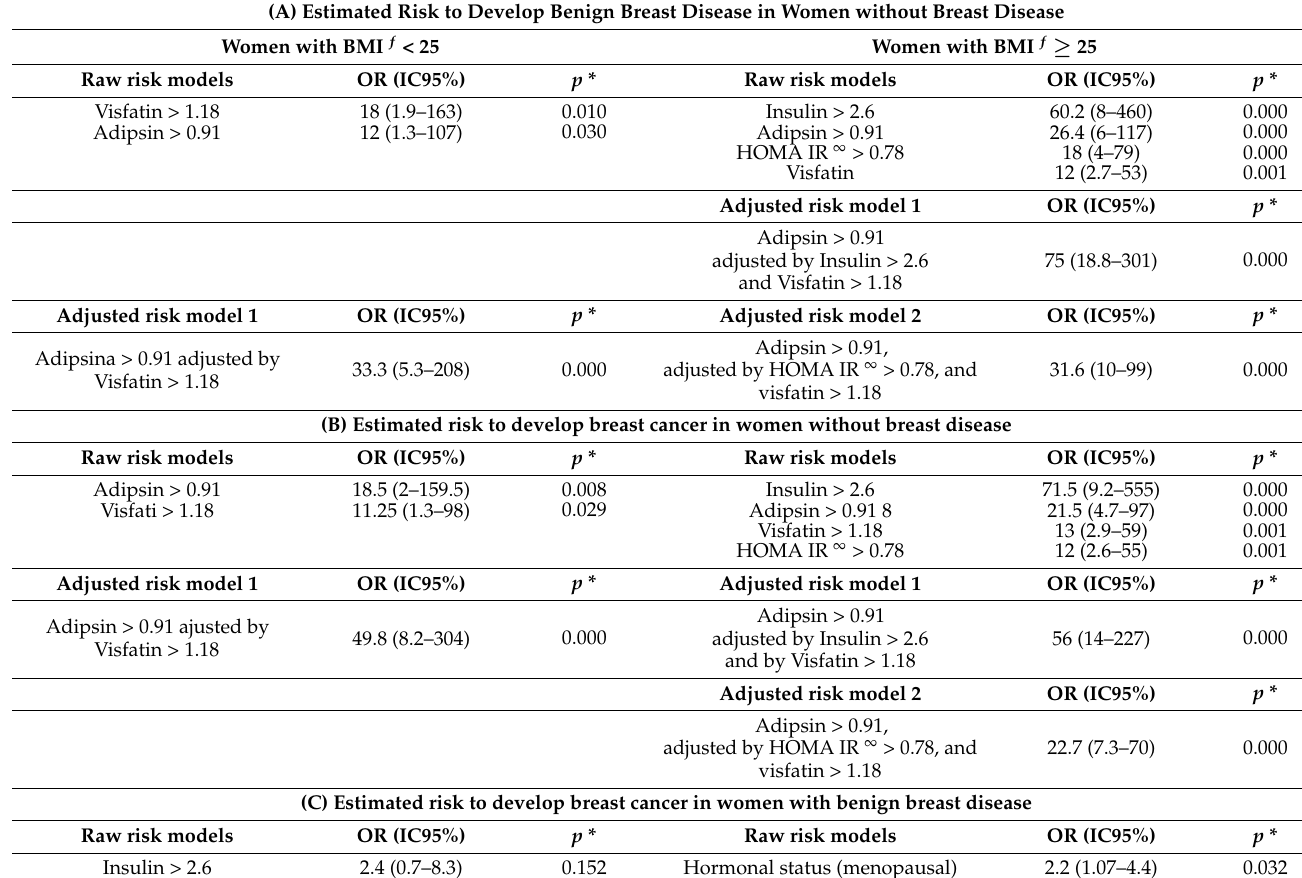
Table 5. Estimated risk to develop benign breast disease and breast cancer in Mexican women (OR calculated through logistic